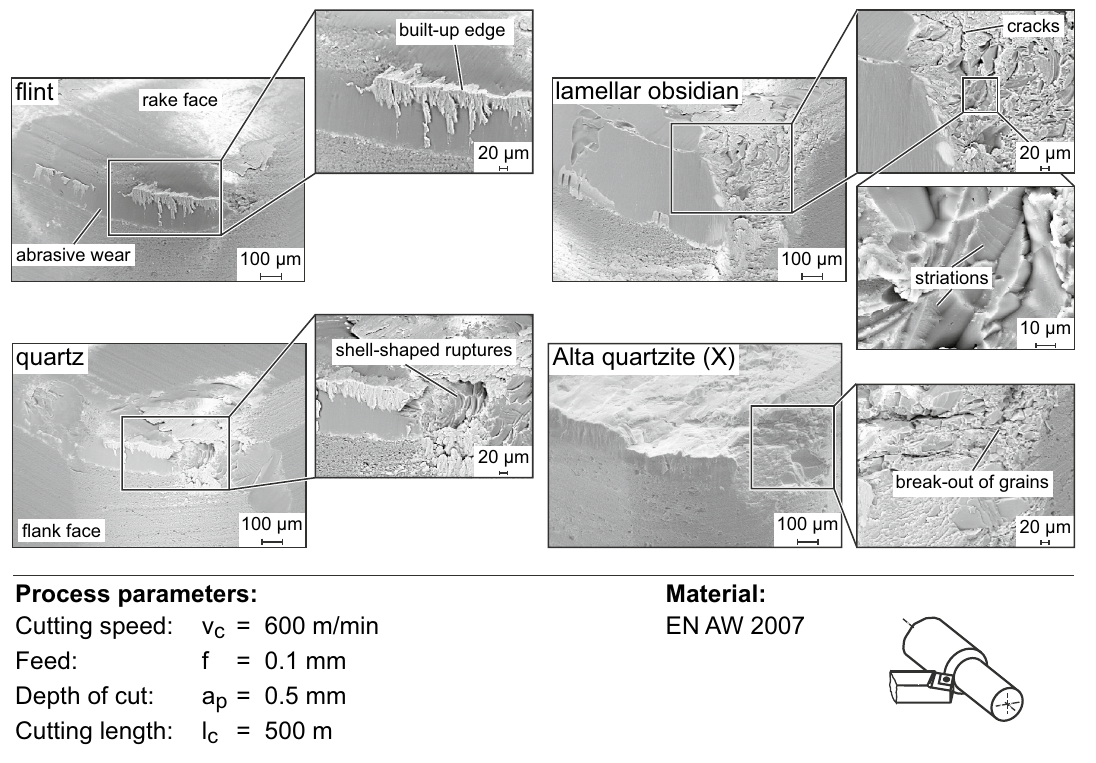
Fig. 16 SEM-images of various wear phenomena that occur after turning of aluminium on rock